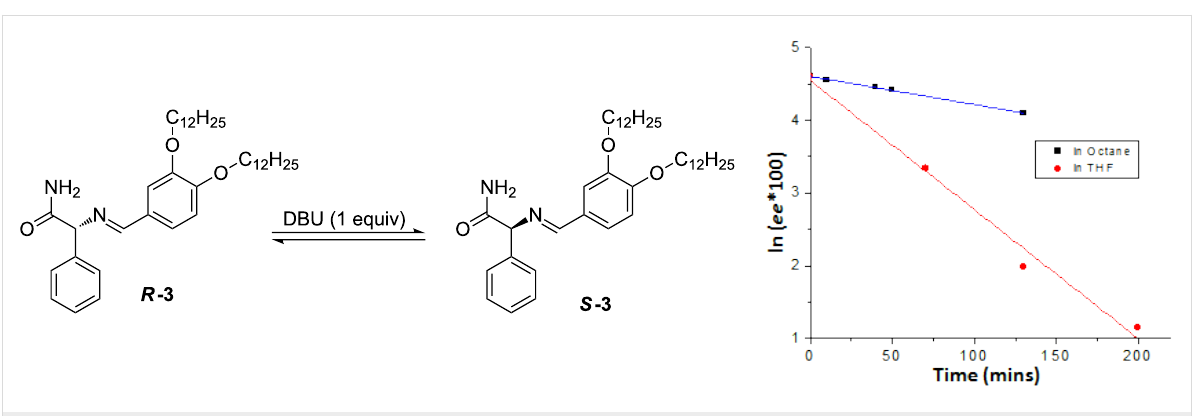
Figure 4: The evolution of ln( ee × 100) for the racemization of R - 3 (1 mM) in the presence of 1 equivalent of DBU in octane and THF.